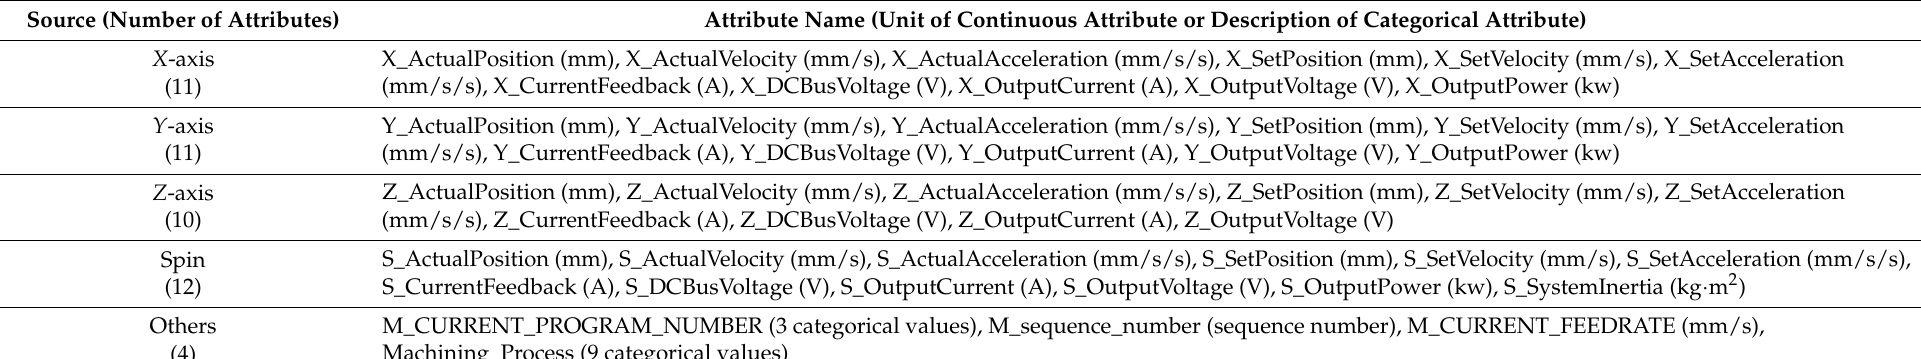
Table 3. Description of attributes in CNC